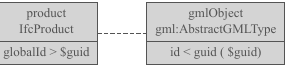
Figure 4. A rule converting a direct attribute to a direct attribute, here GlobalID in IFC to ID in CityGML.